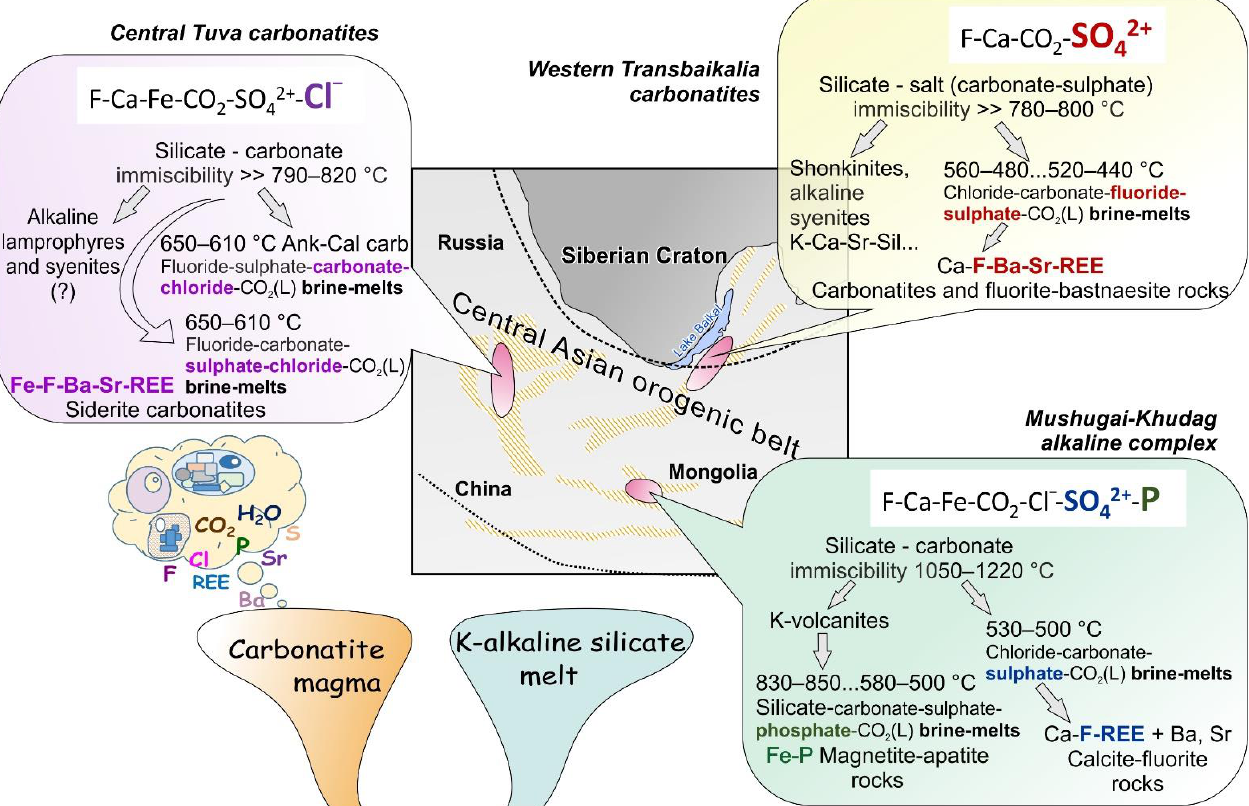
Figure 6. Petrogenetic model of alkaline carbonatite complexes from the Central Asian carbonatite province, depicting information on the composition of melt and brine – melt inclusions that are related to the formation of ore deposits.